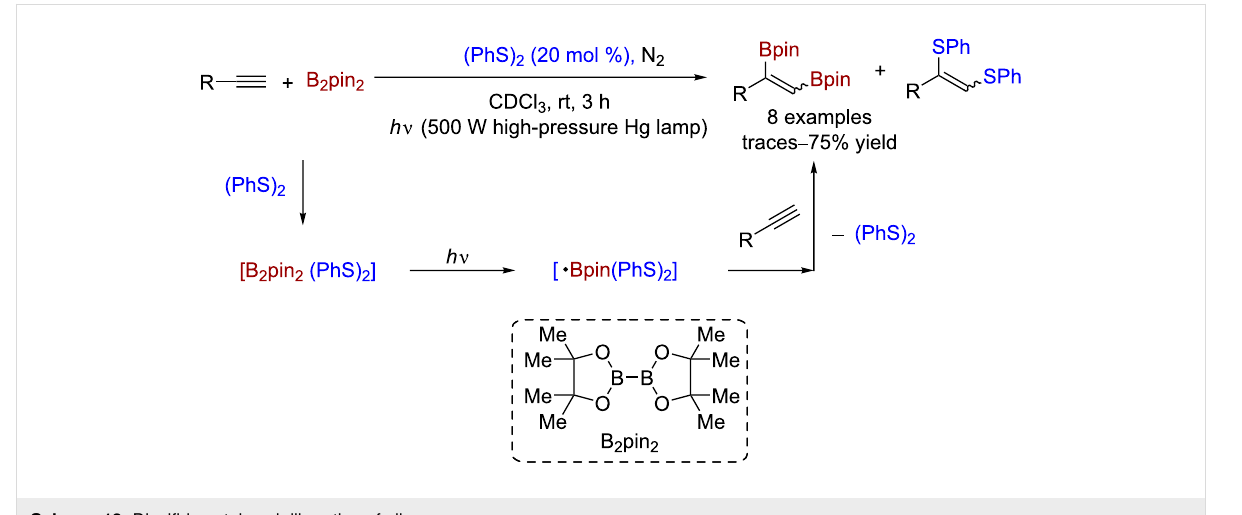
Scheme 13: Disulfide-catalyzed diboration of